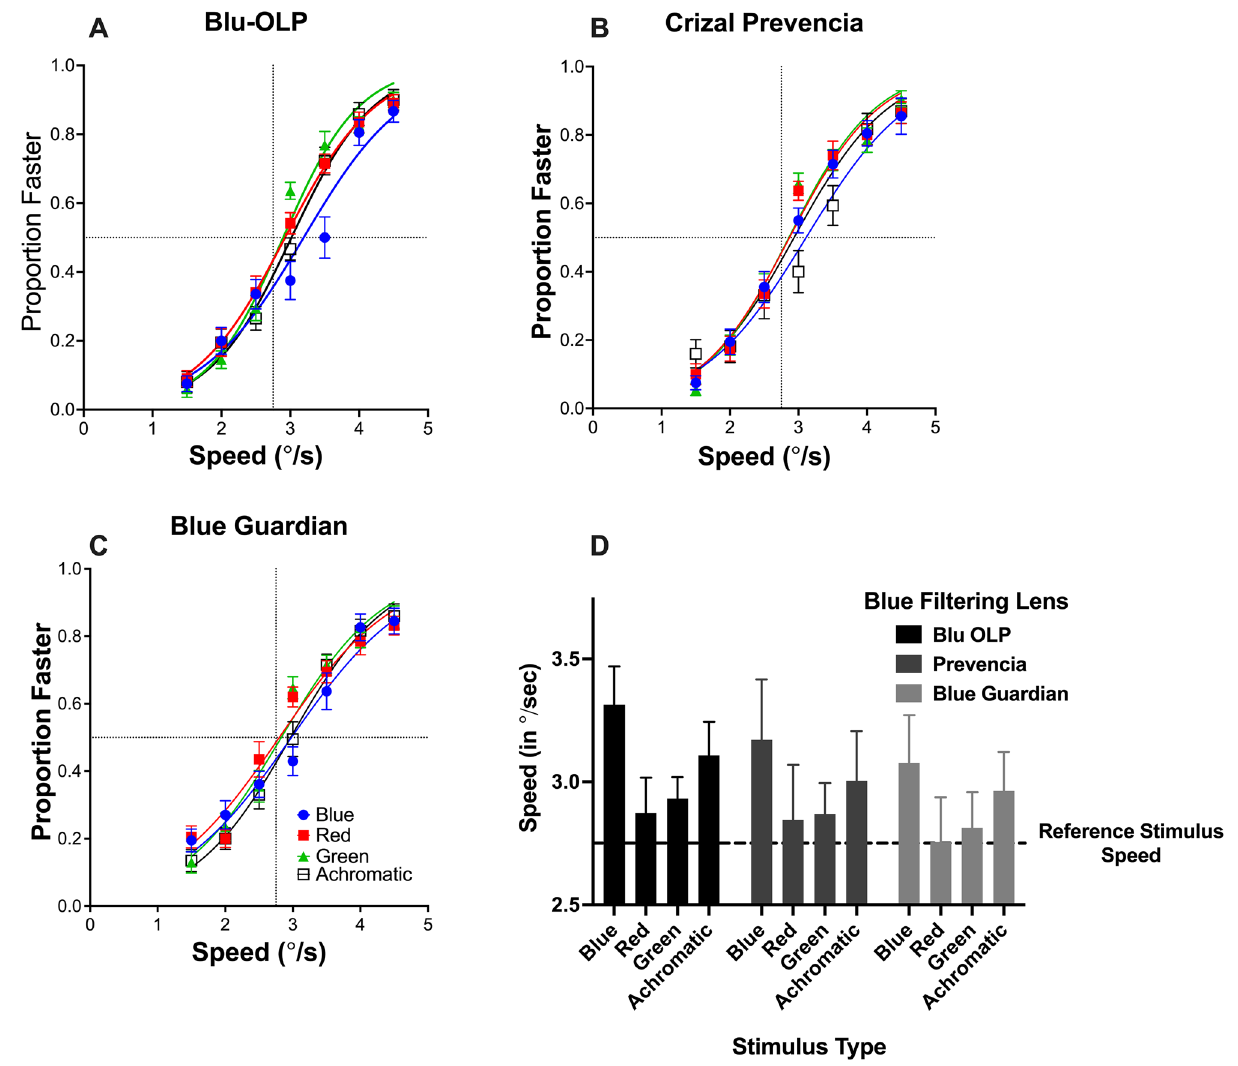
Figure 3. The average proportion of times the test stimulus was judged to be moving faster than the reference stimulus is plotted as a function of the test stimulus speed in ( A – C ), for different coloured stimuli (different colours and symbols). Best fit logistic function fit to data are also shown (solid lines). Error bars represent 95% confidence intervals. In ( D ), the PSE derived from each psychometric function is plotted each BFL and stimulus type. Dotted line represents the speed of the reference stimulus